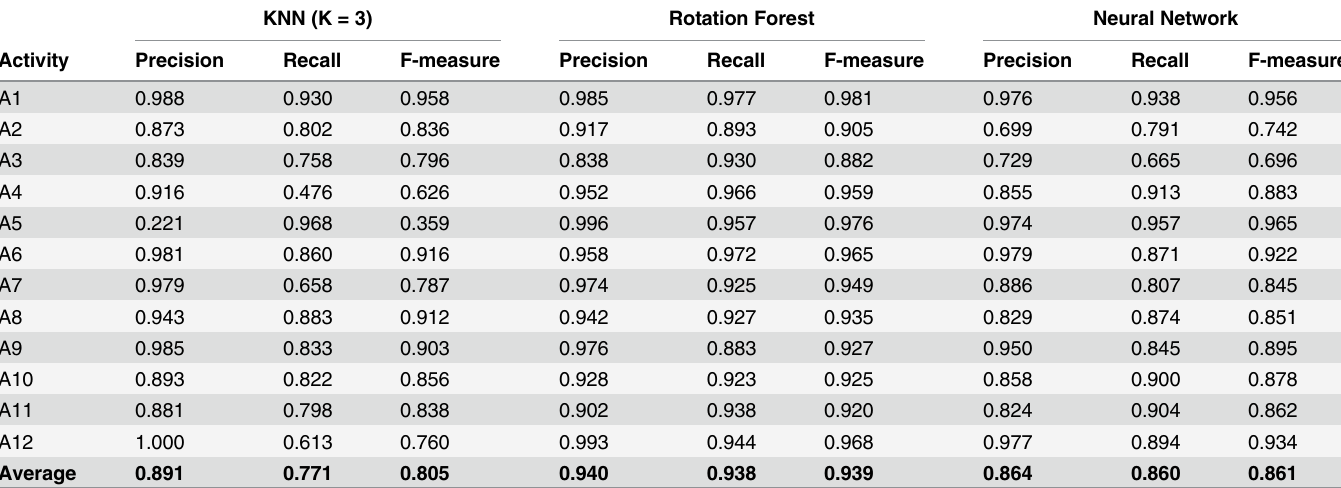
Table 4. Classification results of three classifiers using the acceleration sensor placed on the chest. KNN (K = 3) Rotation Forest Neural Network